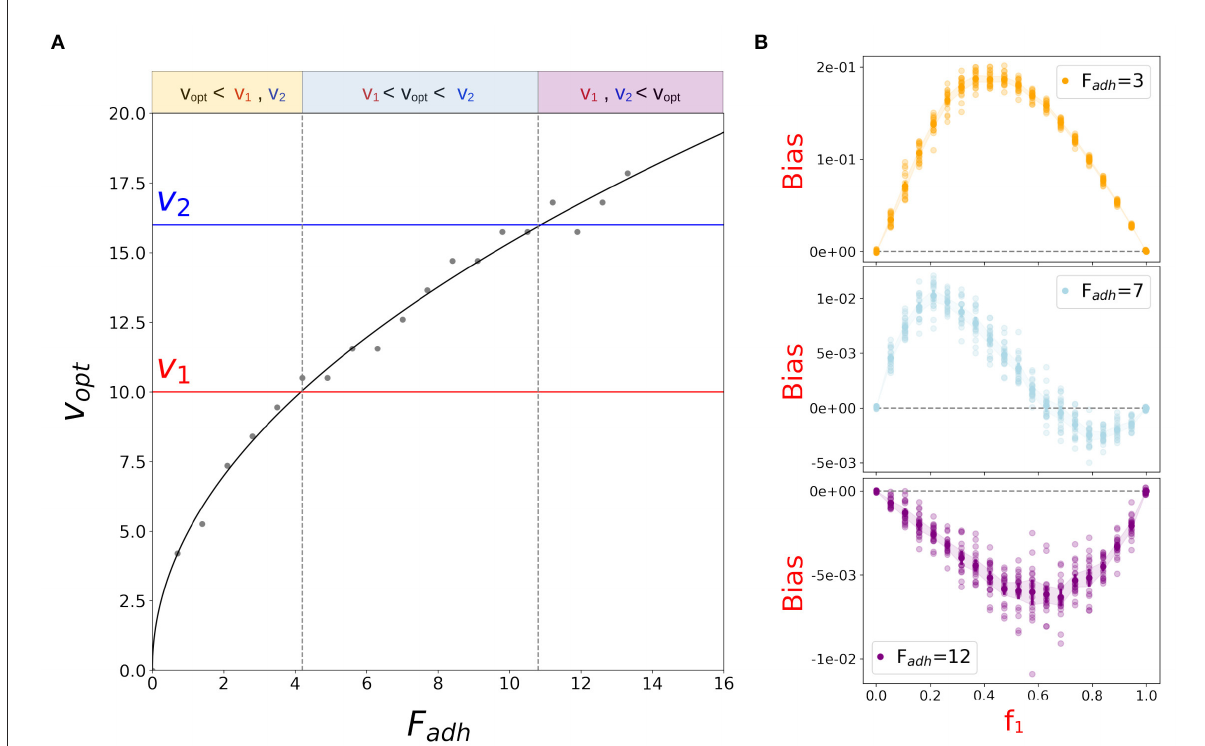
FIGURE7 Particle adhesion affects the outcome of aggregation in binary mixes of particles with heterogeneous speed. (A) Particle speed v opt for which the proportion of aggregated particles at t t f is highest increases with the intensity of adhesive forces F adh (see Supplementary Figure 6). The curve = √ F adh (see Supplementary material for a derivation from microscopic principles) was fitted to the optimal speed obtained from v opt ∼ simulations (gray dots). Three F adh ranges can be defined depending on the relative position of v 1 , v 2 , and v opt (indicated by different colors), as previously discussed for varying v 0 . (B) Aggregation bias of the slower population measured at the end of simulations of the binary mix described 3, F adh 7 and F adh in Figure 5, for adhesive strength within the ranges indicated in the left panel ( F adh = = =